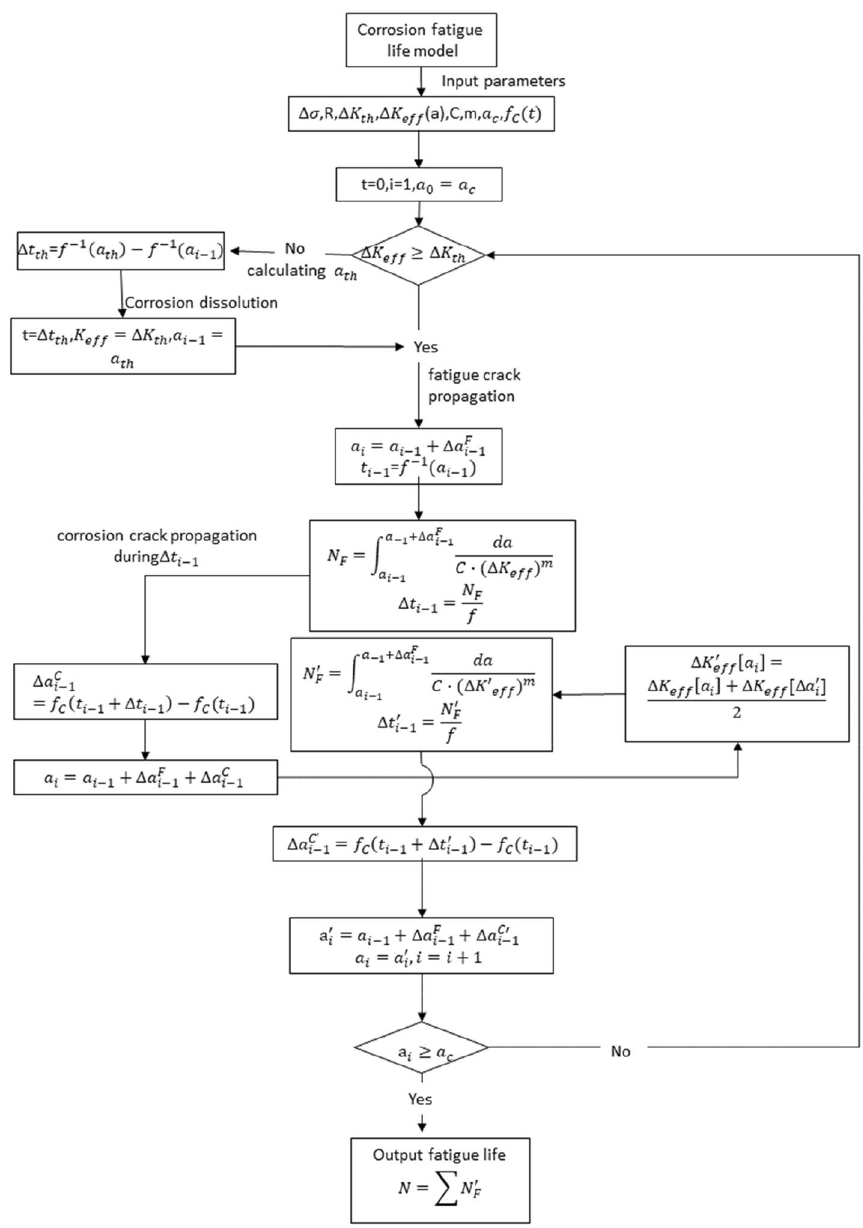
Fig. 3 Discrete substep calculation